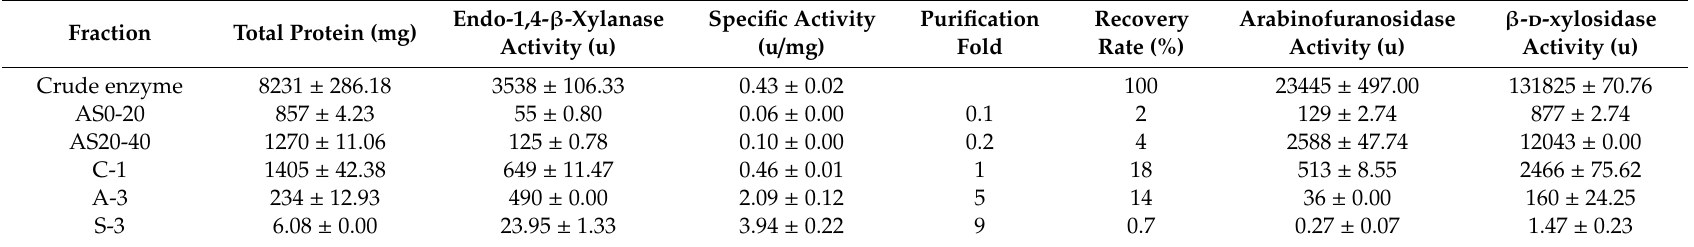
Table 1. Purification of endo-1,4- β -xylanase from wheat